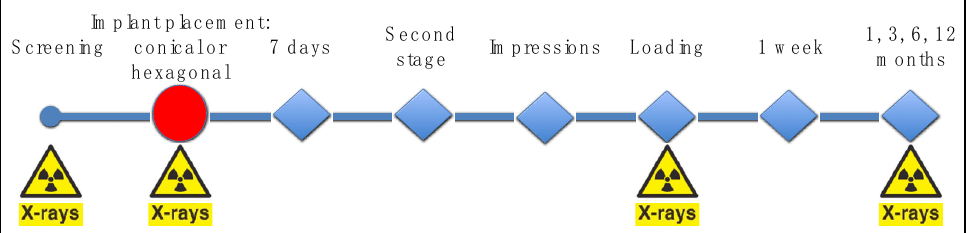
Figure 1. Diagram representing the study visits.